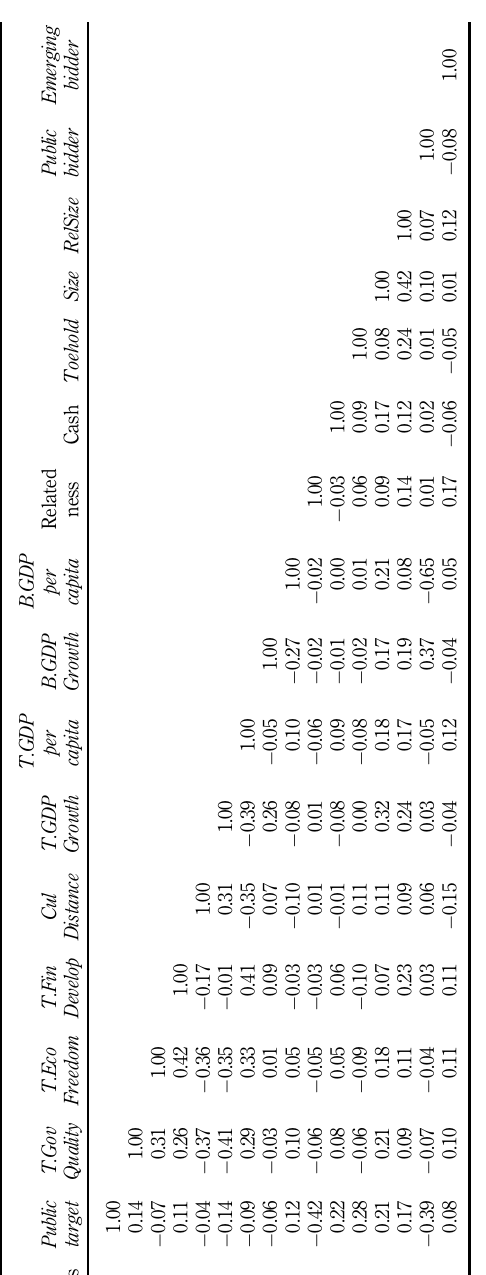
Table A2. Correlation